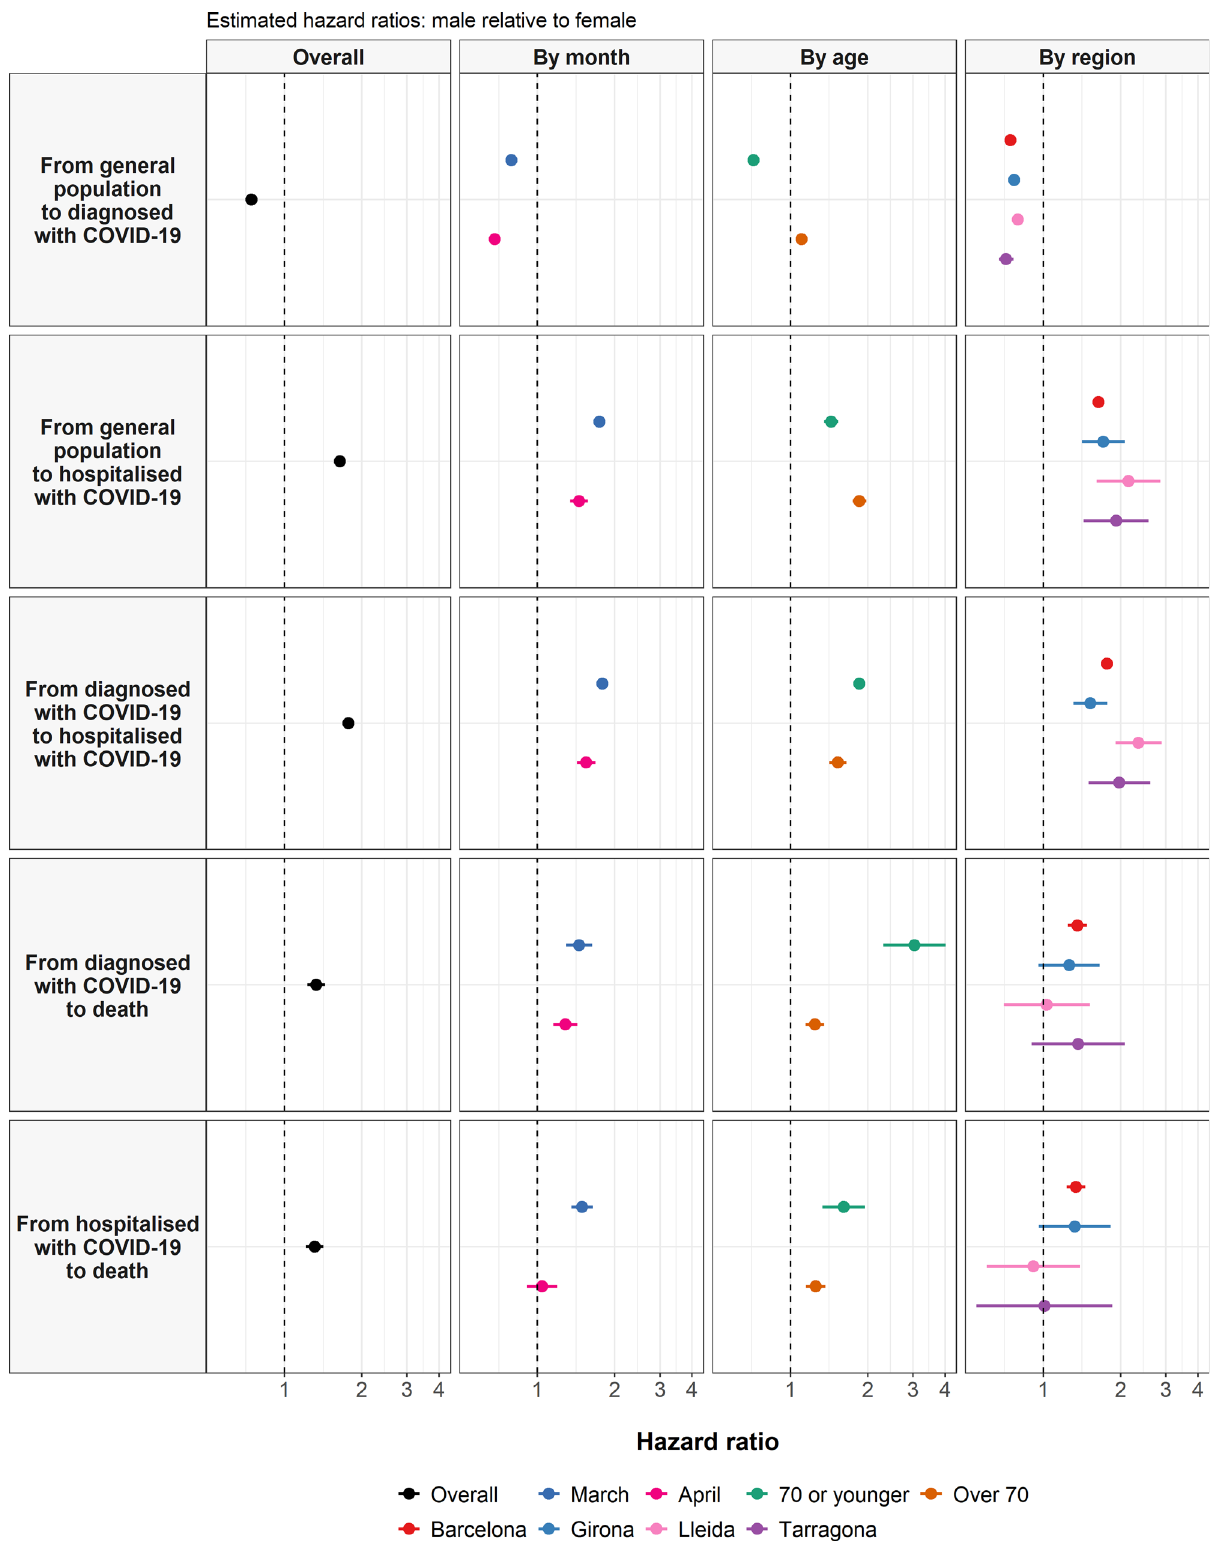
Fig. 5 Sex and COVID-19 transitions. Estimated hazard ratios for male sex (relative to female) from cause-speci fi c Cox models for each transition. Points give estimated hazard ratios, with lines representing 95% con fi dence intervals. The models shown included sex and age as explanatory variables, with the overall models and models strati fi ed by calendar month, sex, and region